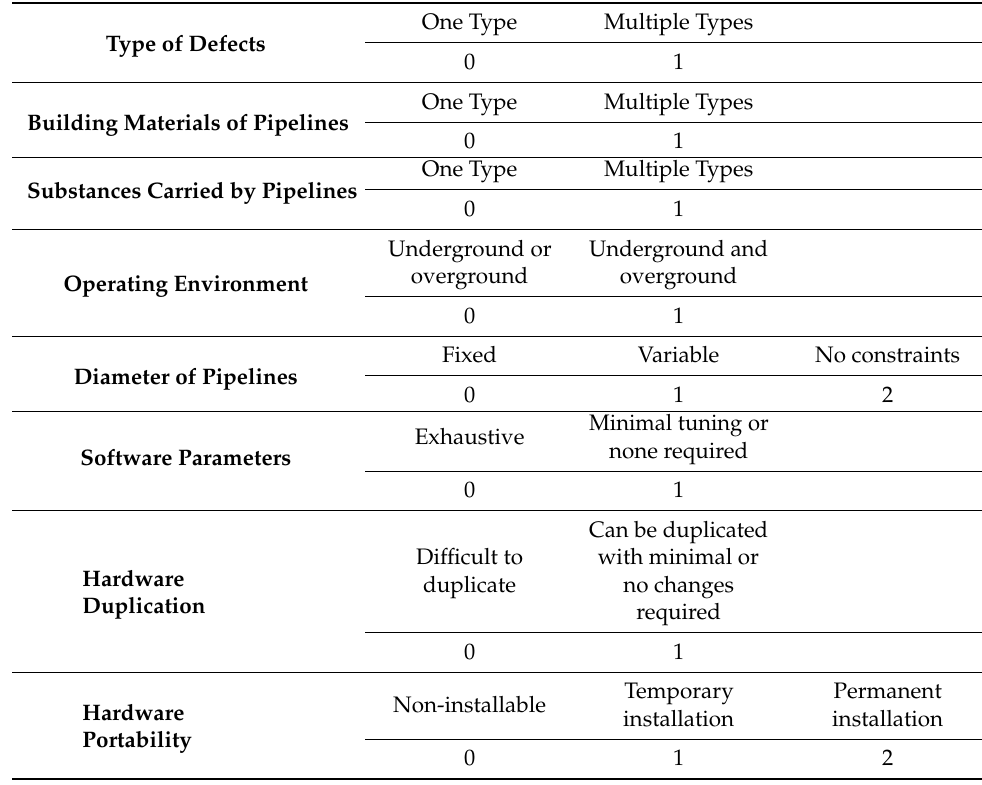
Table 3. The deployability indexes for various pipeline failure detection technologies.